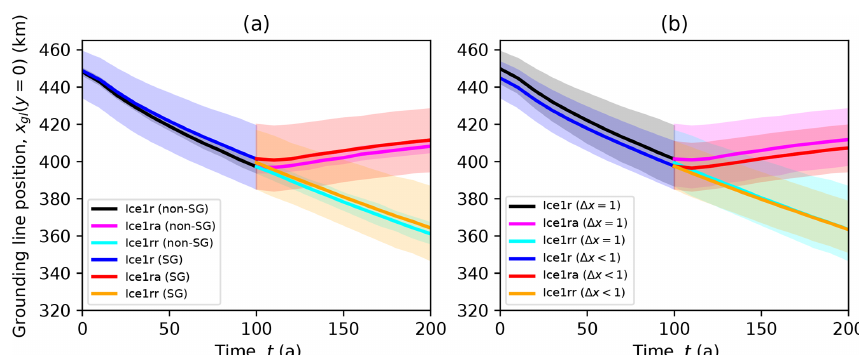
Figure 11. Ice1 midchannel grounding line position plotted for models in the Weertman subgroup with varying numerical treatments. (a) Sub- groups with (SG) and without (non-SG) subgrid friction schemes show similar rates of retreat and advance. (b) Likewise, the subgroup with (cid:49)x = 1km is little different from the subgroup with (cid:49)x < 1km